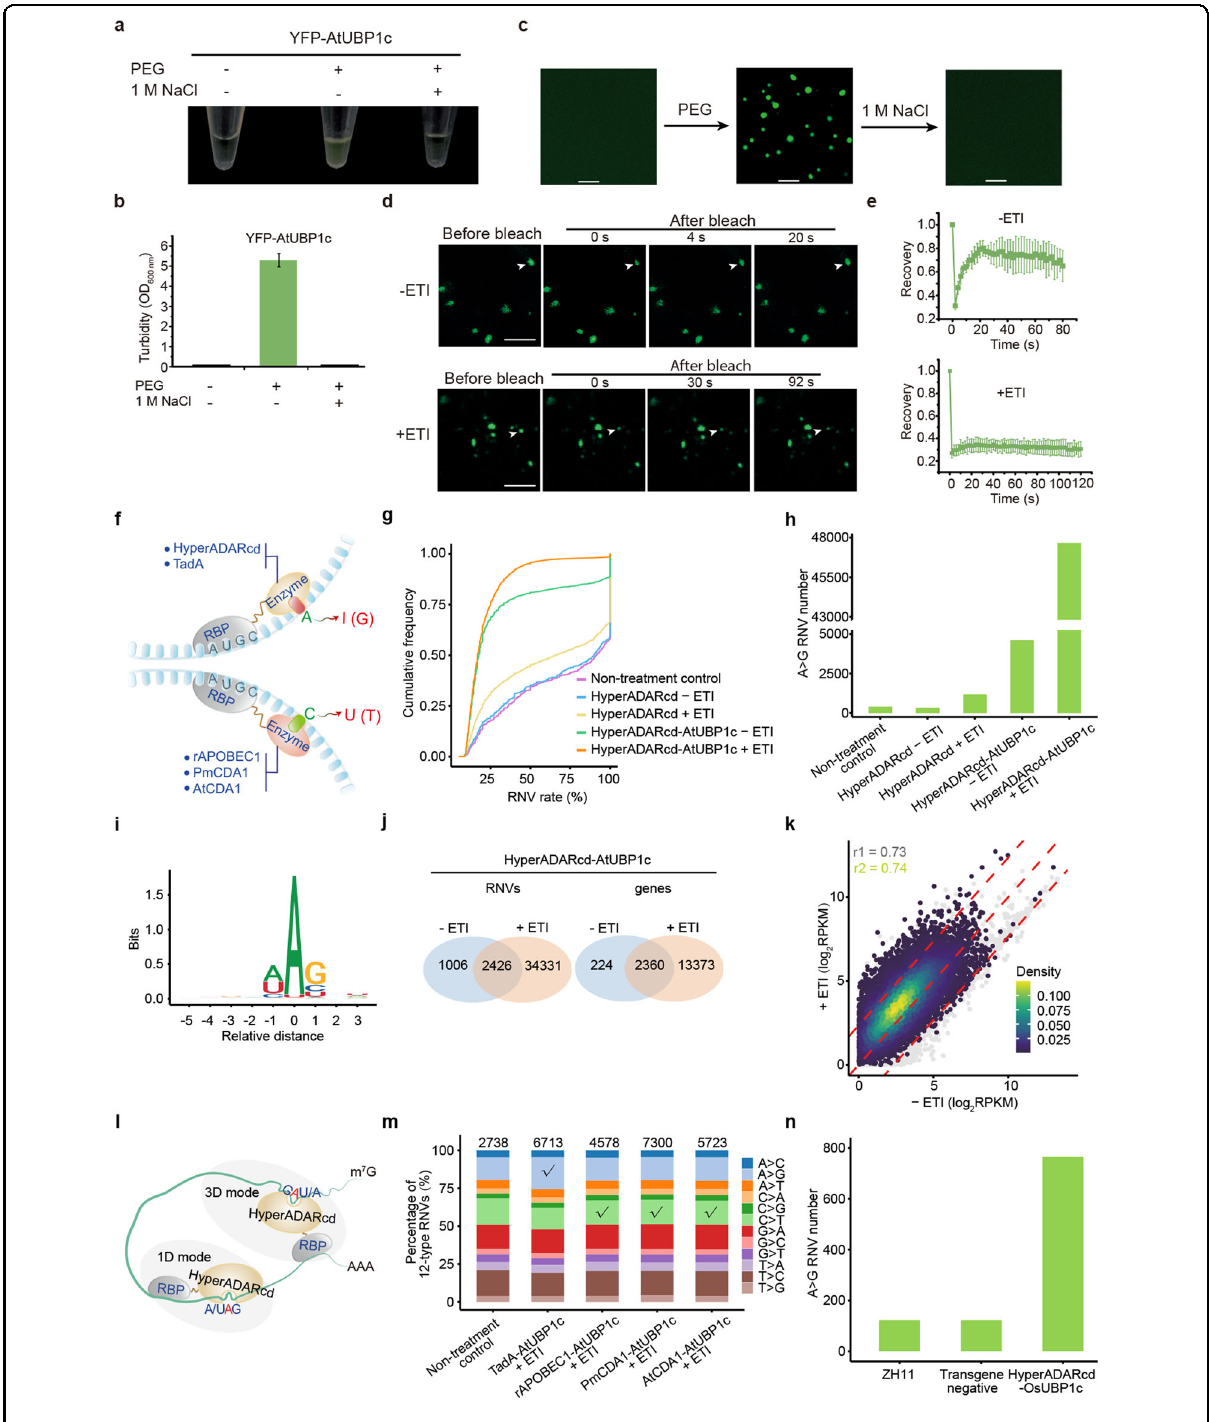
Fig. 1 (See legend on next